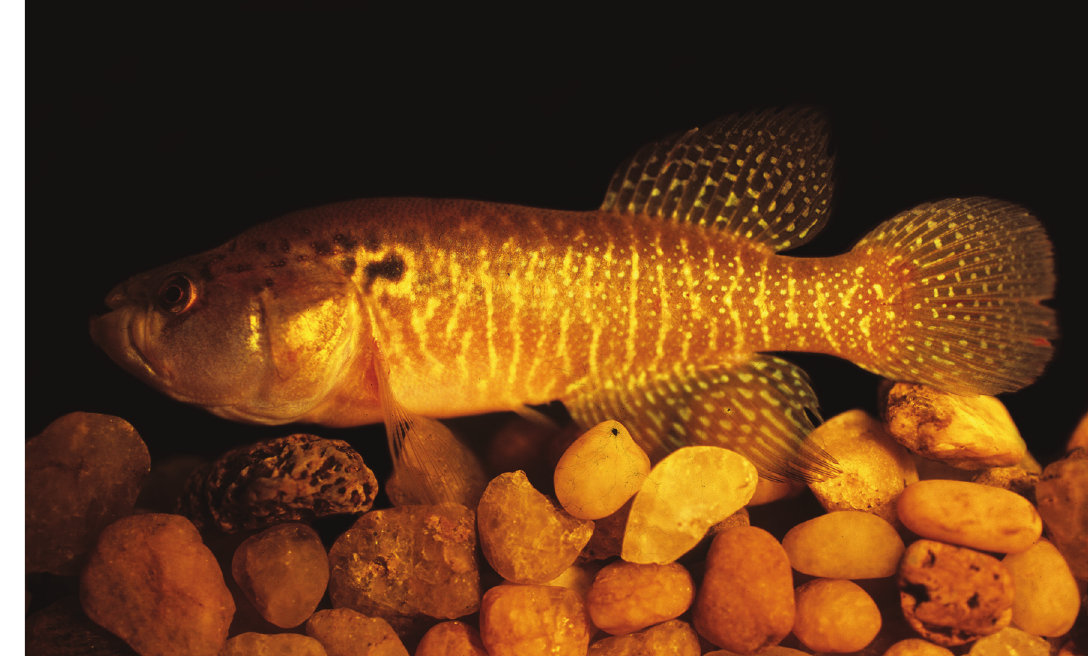
Figure 5. Cynolebias oticus , live paratype, UFRJ 9353, male, 73.5 mm SL. Photograph by W.J.E.M.